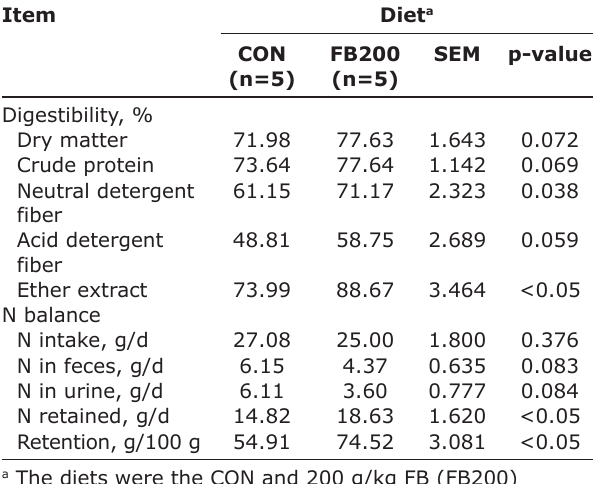
Nutrient intake, g/d